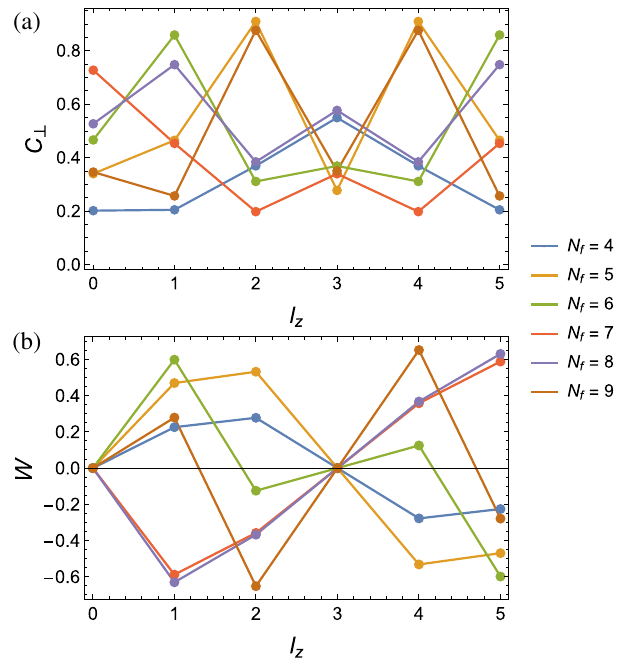
FIG. 5. (a) Maximal antiferromagnetic correlation C ⊥ of the xy component of the spin, and (b) approximate winding number W as function of angular momentum l z ( J 2 ¼ 0 . 5 ; K ¼ 0 . 05 ) for states with N f ¼ 4 ; 5 ; … ; 9 flipped spins. Correlations are largest when the selection rule Eq. (11) is obeyed. For N f ¼ 5 , 6, 8, 9 also the winding number W peaks at the expected value given by Eq. (11). For N f ¼ 4 , 7 instead, both skyrmion and antiskyrmion are in the l z ¼ 0 sector and the ground state is a linear super- position of skyrmion and antiskyrmion with vanishing winding